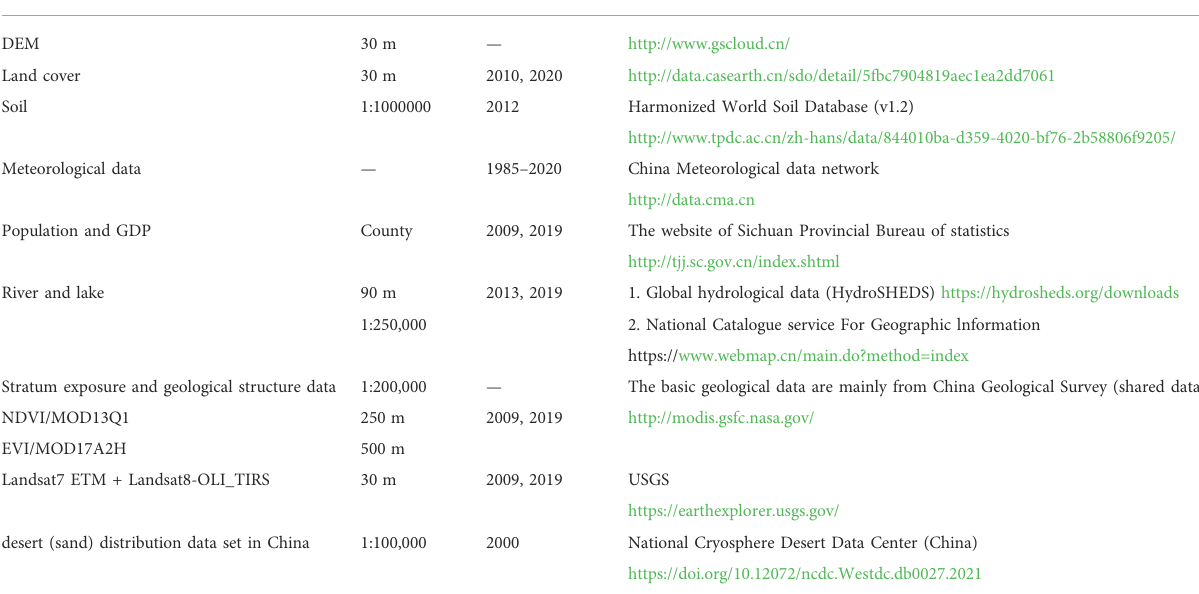
TABLE 1 Basic information of data